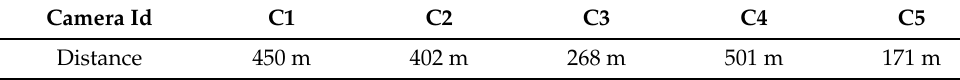
Table 1. Distances between the camera and the nearest visibility